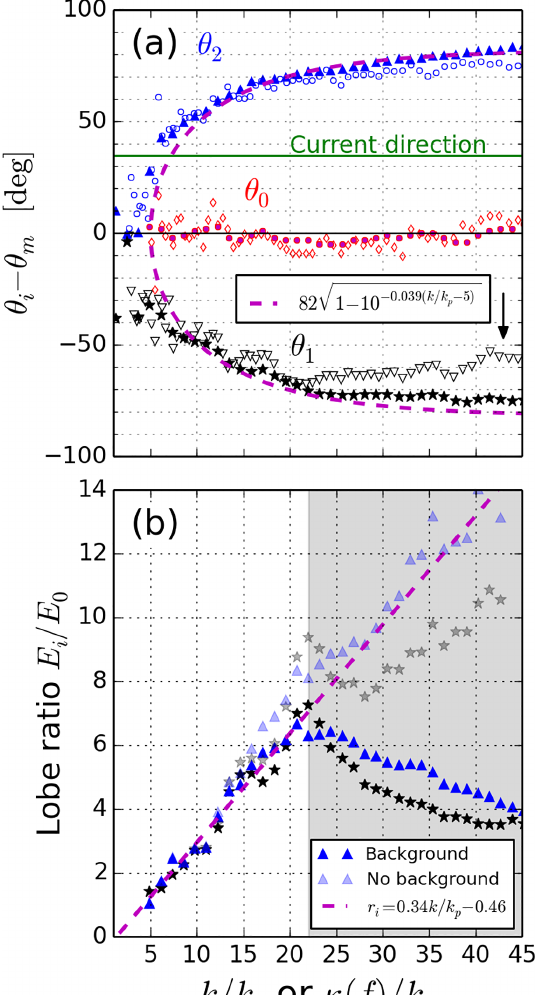
Figure 5. Bimodal directional distribution characteristics from stereo video as a function of normalized wavenumber. (a) Peak positions. (b) Lobe ratios. Empty markers correspond to constant frequency estimates and full markers to constant wavenumber esti- mates (see Fig. 4 for